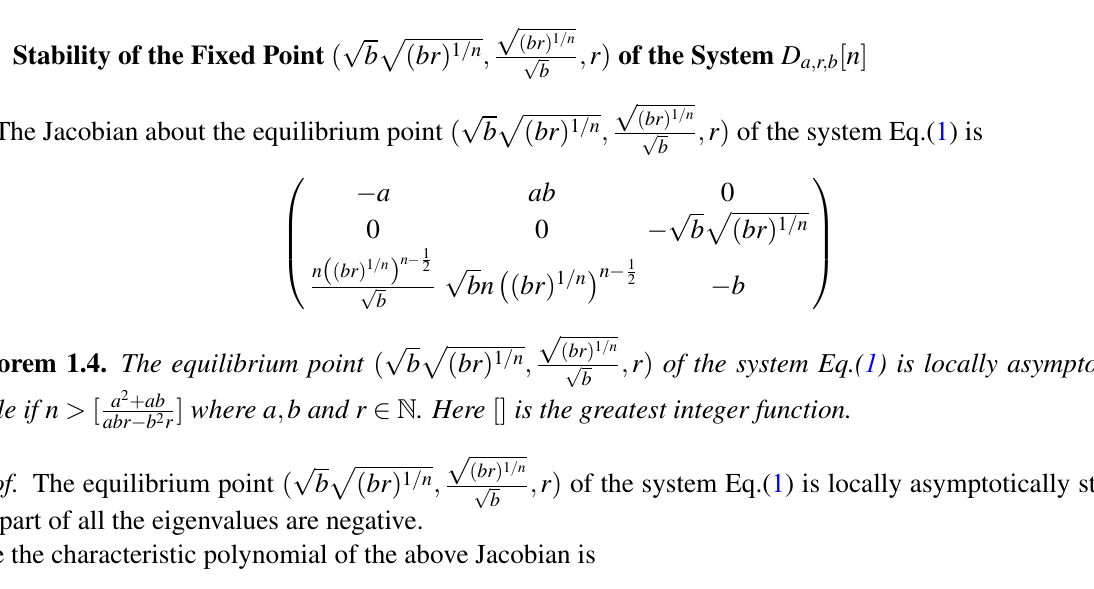
√ √ (cid:112) ( br ) 1 / n b , r ) of the System D ( br ) 1 / n , √ b